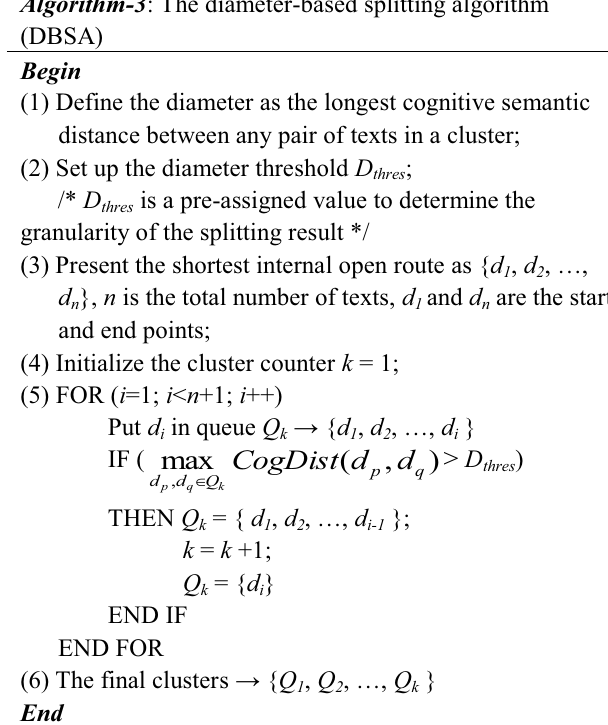
Algorithm-3 : The diameter-based splitting